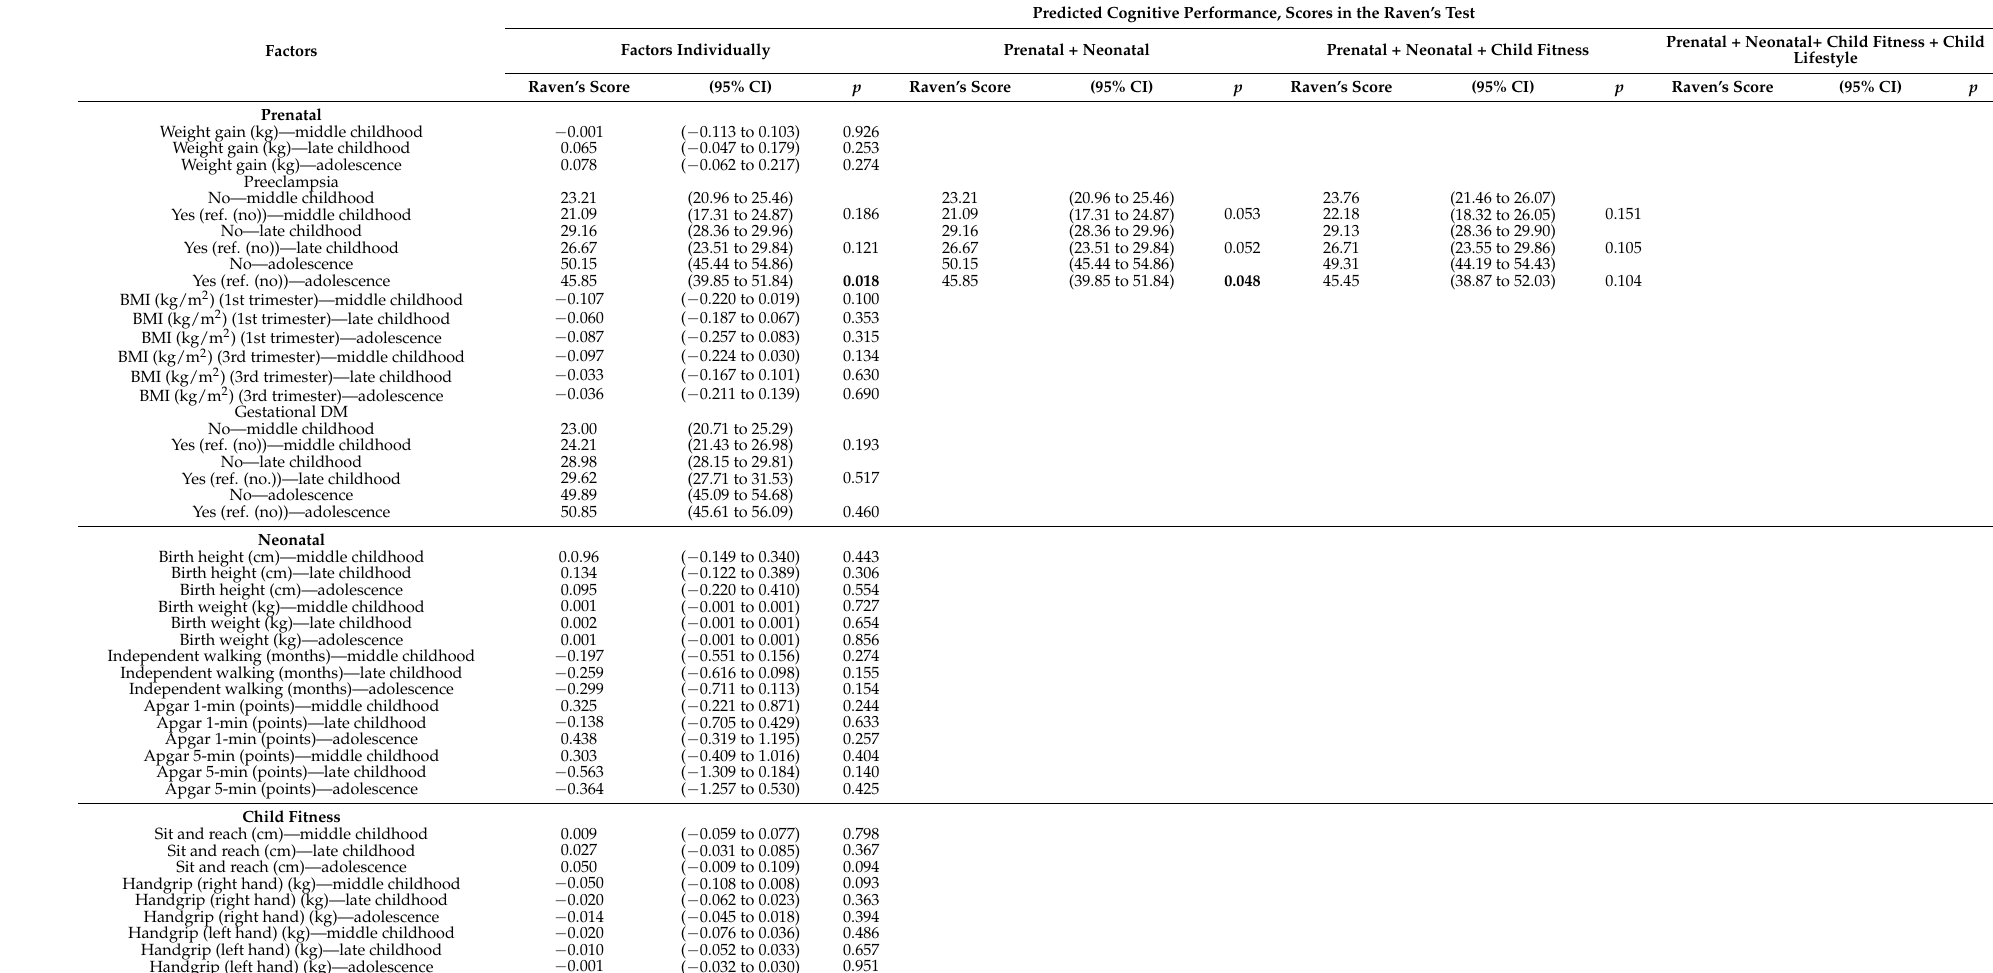
Predicted Cognitive Performance, Scores in the Raven’s